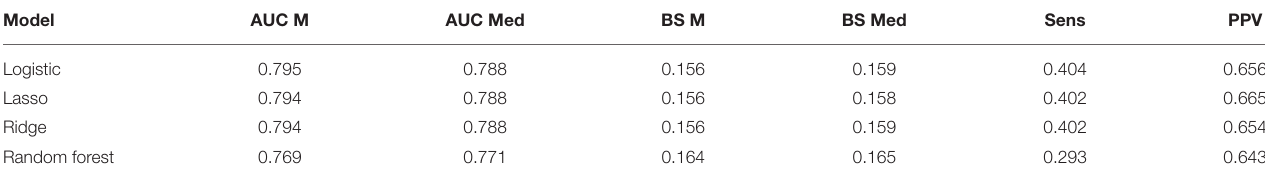
TABLE 2 | Overview of the performance estimates for each prediction model.